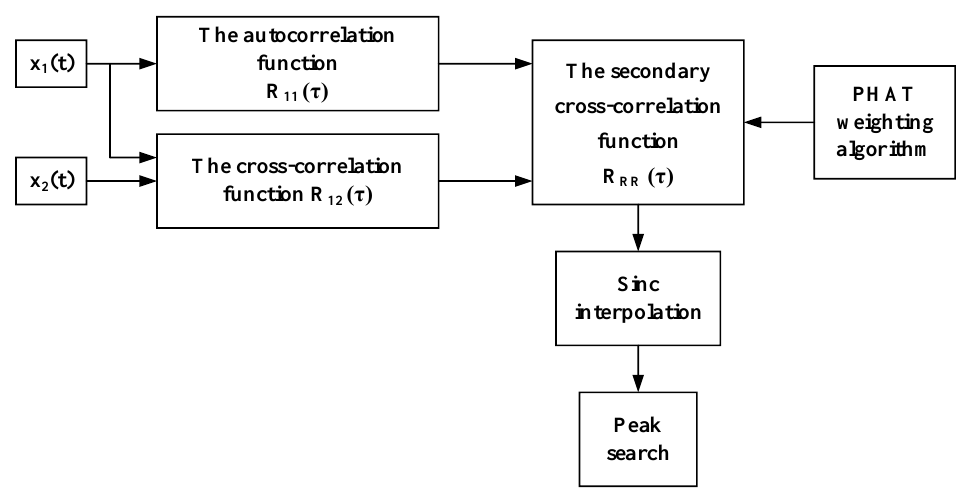
Figure 2. Schematic of the implementation of the secondary PHAT cross-correlation.